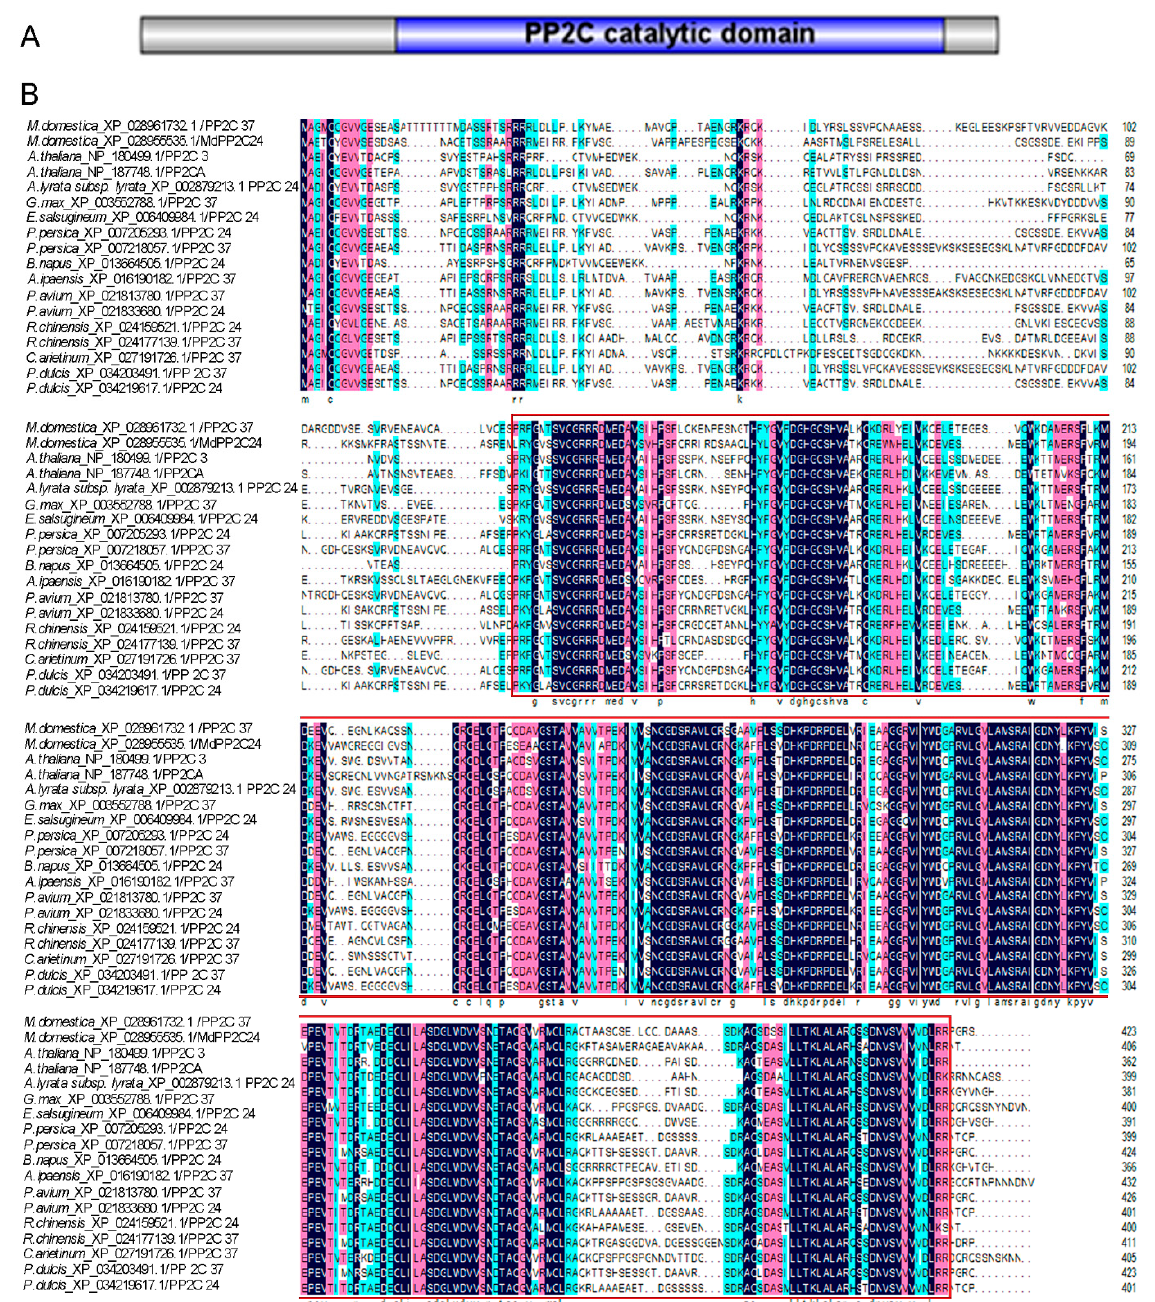
Figure 1. The amino acid sequence analysis of MdPP2C24/37. ( A ) Both MdPP2C24/37 were predicted to have PP2C catalytic domains. ( B ) Sequence analysis indicated that MdPP2C24/37 are highly conserved proteins analogous to proteins in Arabidopsis thaliana , Arabidopsis lyrata subsp. Lyrata , Arachis ipaensis , Brassica napus , Cicer arietinum , Eutrema salsugineum , Glycine max , Rosa chinensis , Prunus persica , Prunus avium, and Prunus dulcis.